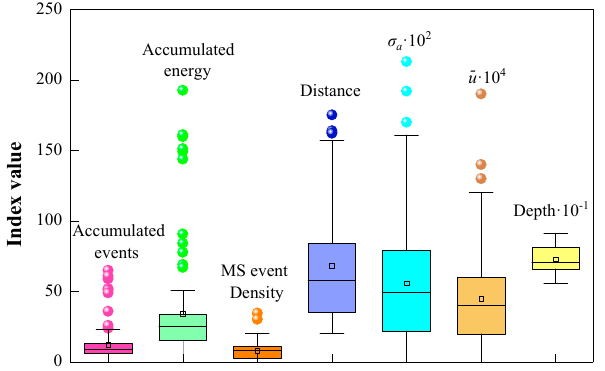
Figure 6. Box plot of the distribution of the seven evaluation indexes. Table 5. Statistical distribution parameter table of evaluation indicators for different damage levels.